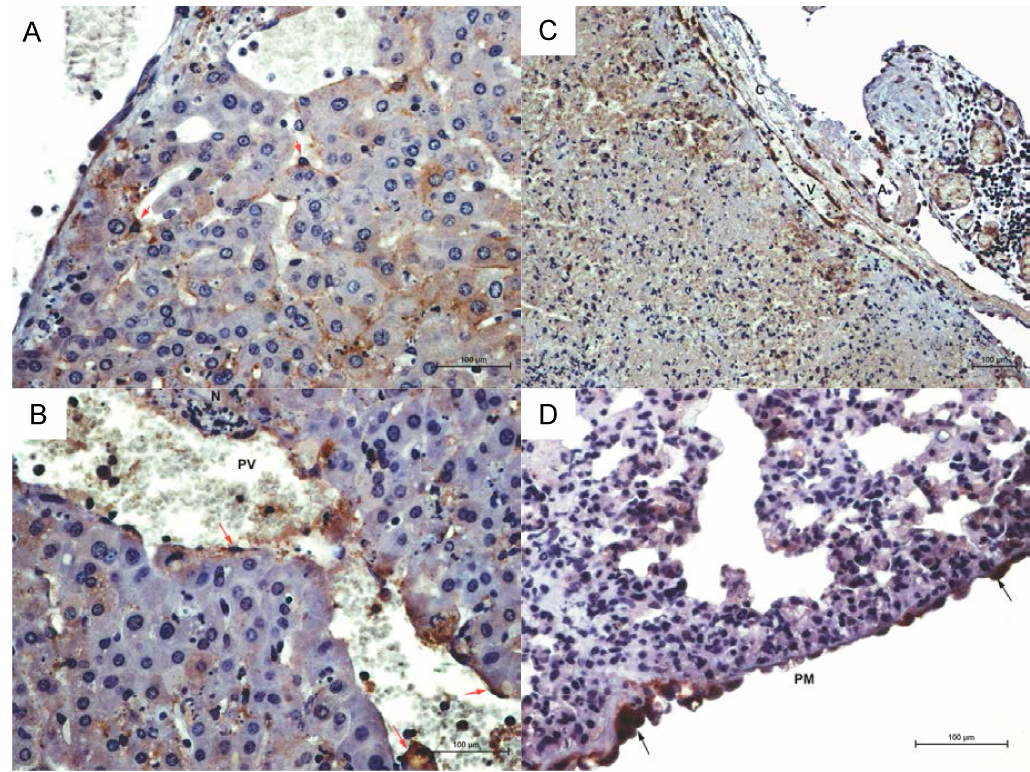
Figure 3. Immunohistochemistry of PIRV-infected hamsters. ( A ) Multifocal immunoreactivity is evident in activated Kupffer cells (red arrows) (original magnification 200×) ( B ) Immunoreactivity is evident in the endothelial lining of PV (red arrows, original magnification). ( C ) Spleen of infected hamster showing strong immunoreactivity of capsular (C) vessels especially veins (V) and to a lesser degree in arteries (A) (original magnification 100×). ( D ) Arrows indicate strong immunoreactivity in hypertrophic and hyperplastic pleural mesothelium (PM) (original magnification 200×). Bar indicates 100 micrometers.